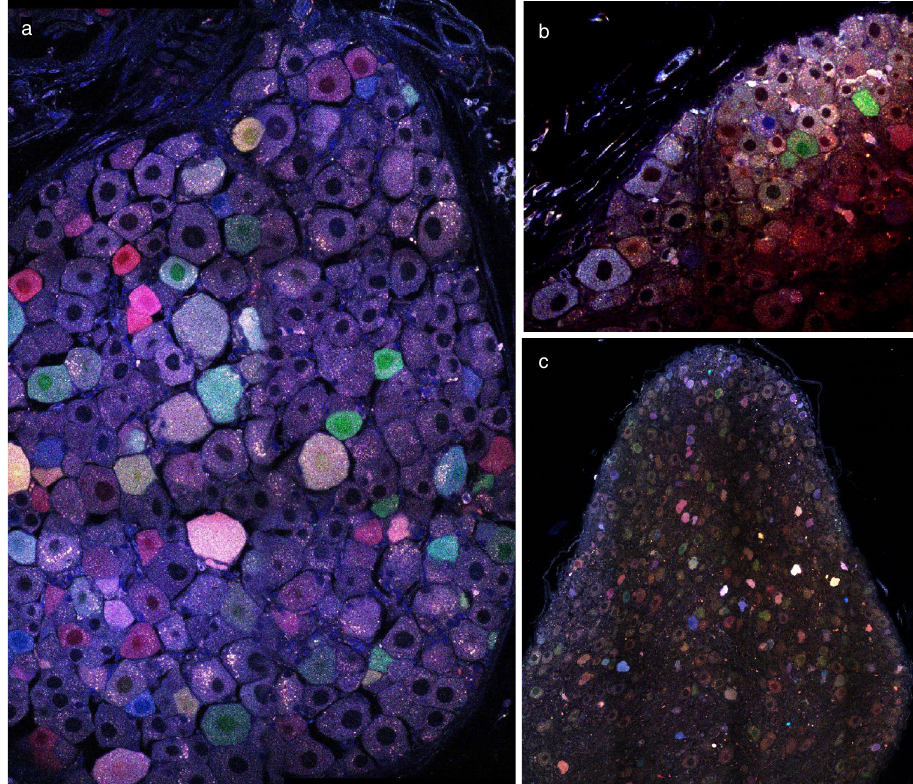
Figure 4. Sensory and sympathetic nerves were also transfected by multicolor AAV9. ( a ) DRG, ( b ) vagal ganglion, and ( c ) superior cervical ganglion showing nerve cell bodies labeled with multicolored AAVs. Total viral dose 1 × 10 12